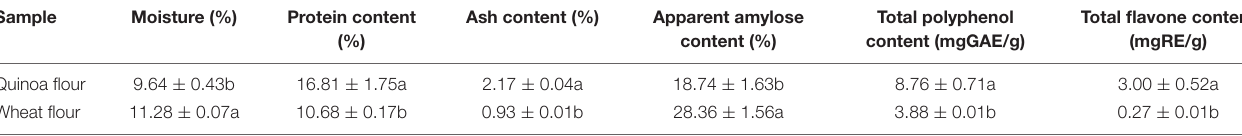
TABLE 1 | Compositional characteristics of quinoa and wheat flours.